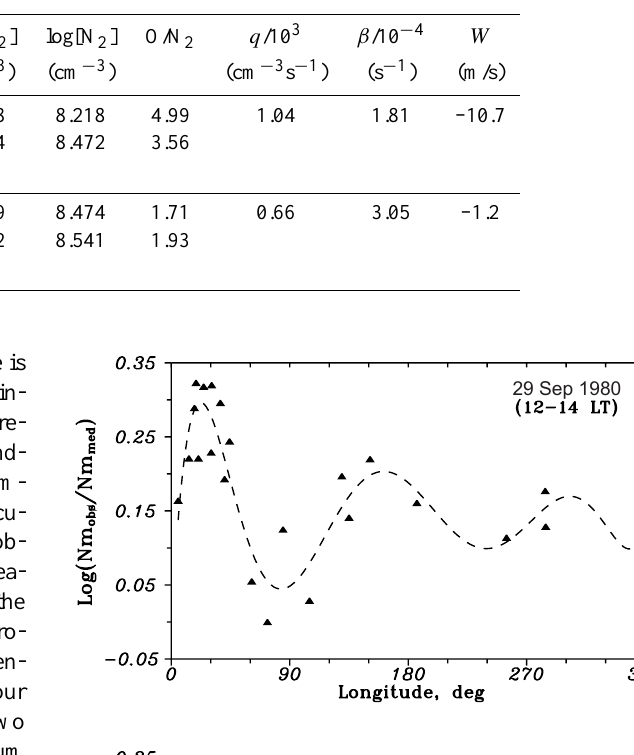
Table 5. Aeronomic parameters calculated for 300 km height and 12 LT at Millstone Hill for winter and summer days. MSIS-83 model values (second line) are given for comparison